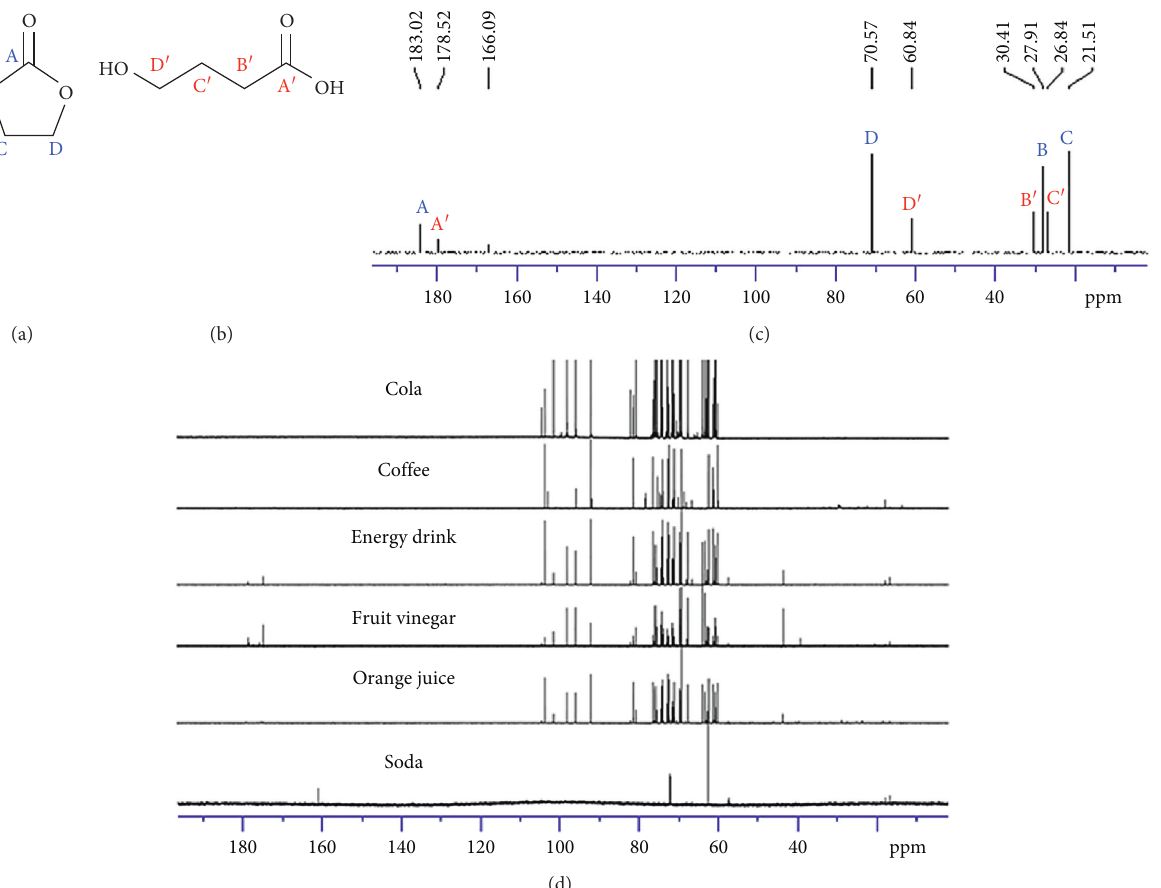
Figure 3: The chemical structure of GBL (a) and GHB (b). The 13C-NMR spectrum of GBL spiked into 0.2% aqueous solution of formic acid (c) and beverages without GBL